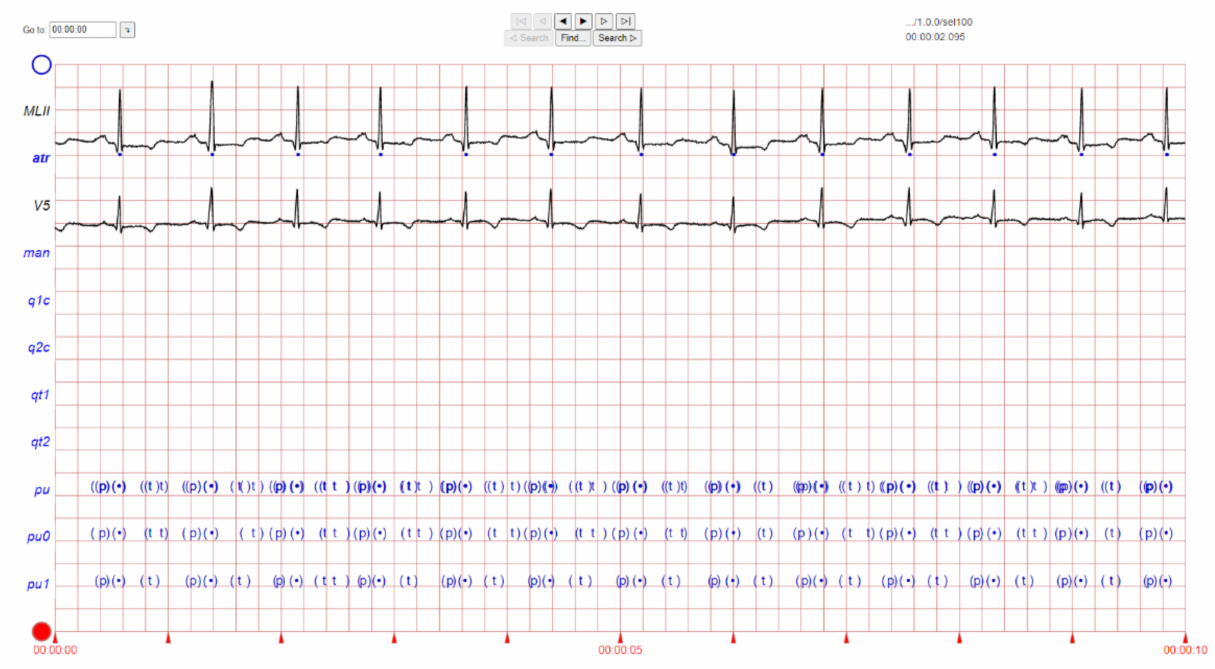
Figure 3. ECG image data for ‘arrhythmia’ abnormality.